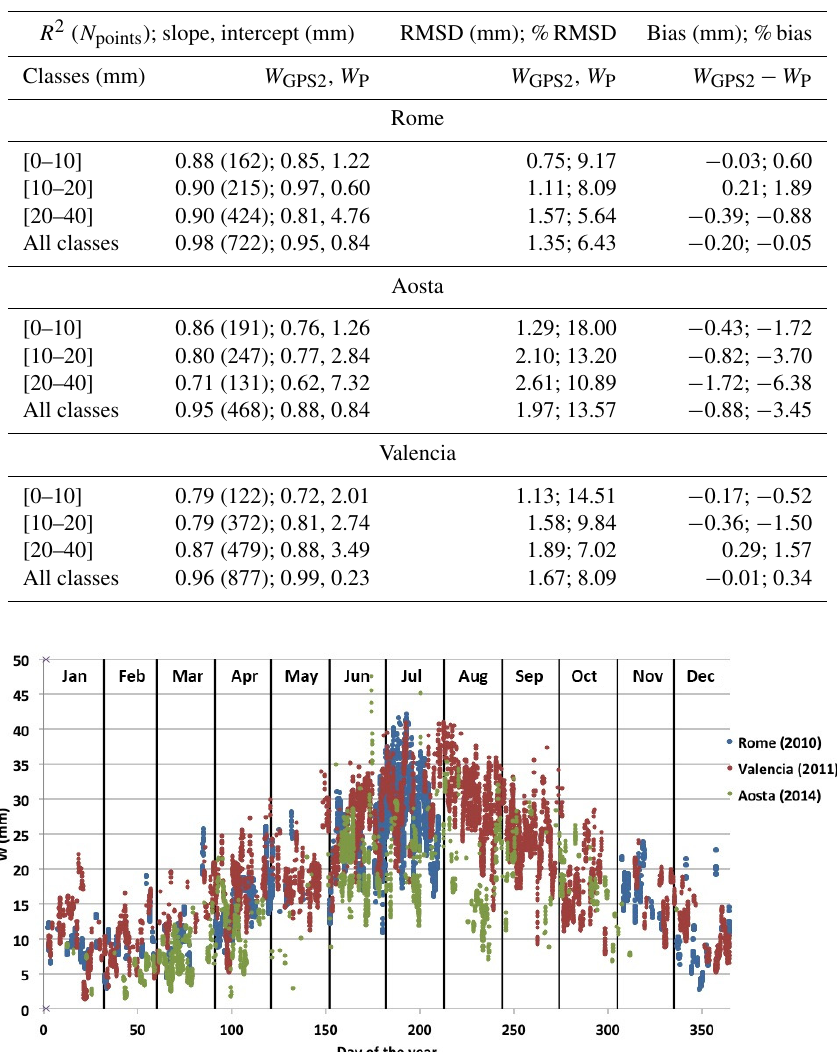
Table 3. Parameters of the statistical analysis in the comparison against sun photometer and GPS water vapour estimations: squared correla- tion coefficient, slope and intercept of the fitting lines, RMSD and bias.